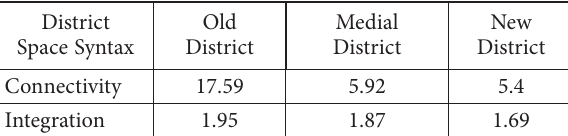
Table 6. The obtained data from the theory of space syntax in the three studied districts (source: